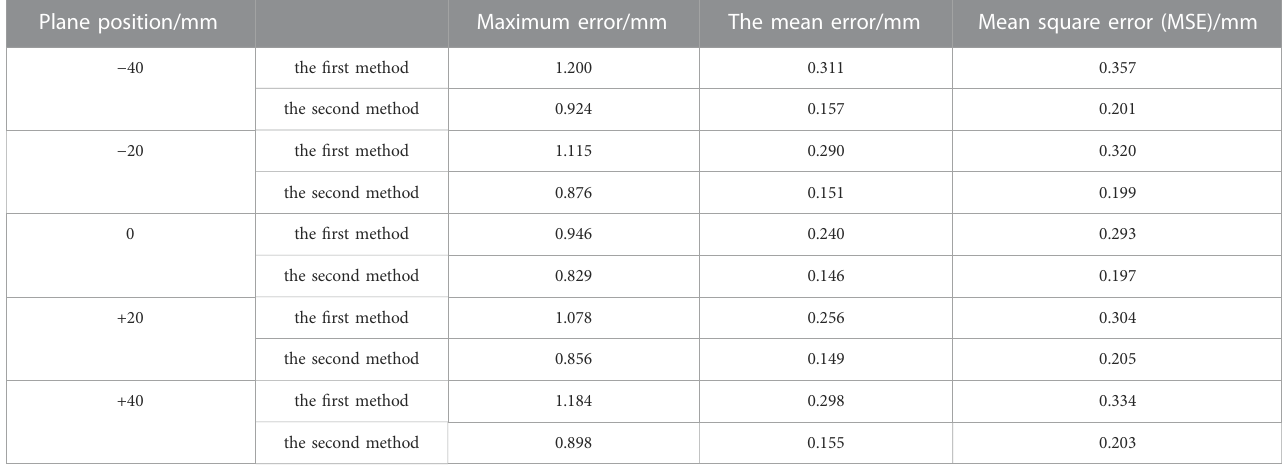
TABLE 2 Plane measurement errors in three-dimensional measurement. Plane